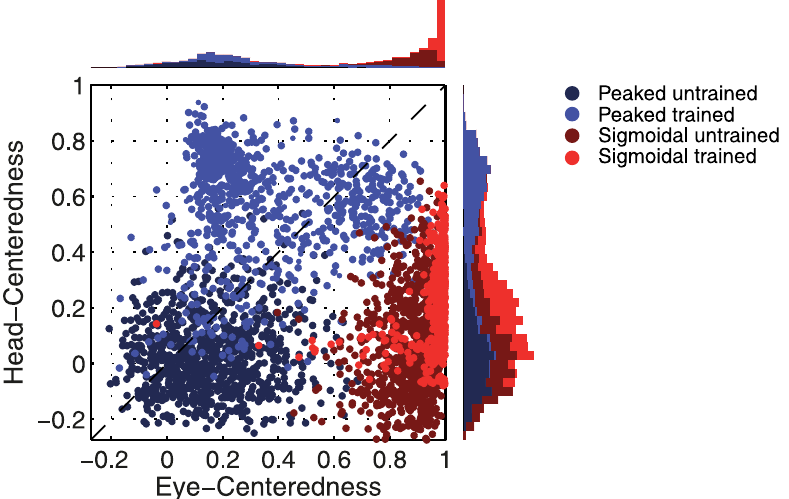
Fig 5. Scatter plot of eye-centredness and head-centredness values of output neurons from simulations with peaked and monotonic gain modulation. The scatter plot shows the eye-centredness and head-centredness values of all output neurons from four separate simulations corresponding to the models with peaked and sigmoidal (monotonic) gain modulation tested before and after training with the standard trace rule (Eq 6). Each point in the scatter plot corresponds to an output neuron from the given simulation, plotted in terms of its eye-centredness (abscissa) and head-centredness (ordinate). The dashed diagonal line with positive unity slope separates those neurons which are classified as head-centred (above line) from those that are classified as eye-centred (below the line). It is evident that after training most of the output neurons from the network with peaked gain modulation have become head-centred, while nearly all of the output neurons from the network with monotonic gain modulation have remained eye-centred.